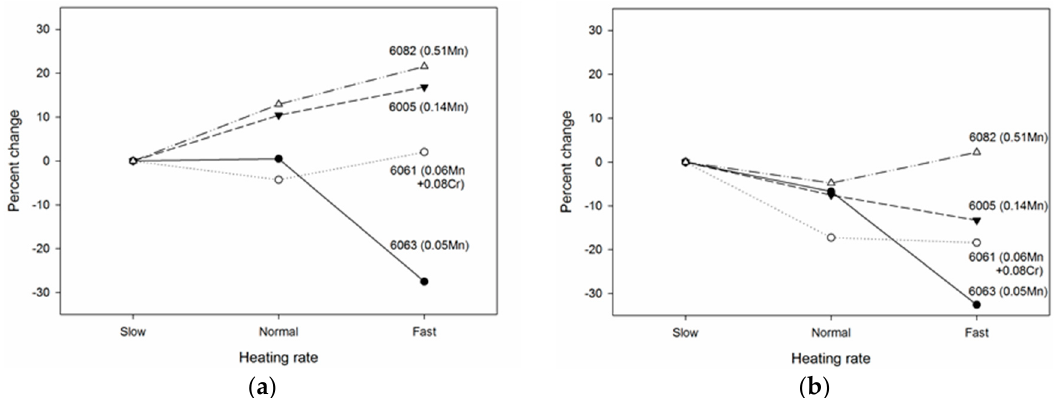
Figure 13. Percent change in dispersoid number density ( a ) and % area (b ) as a function of the heating rate.